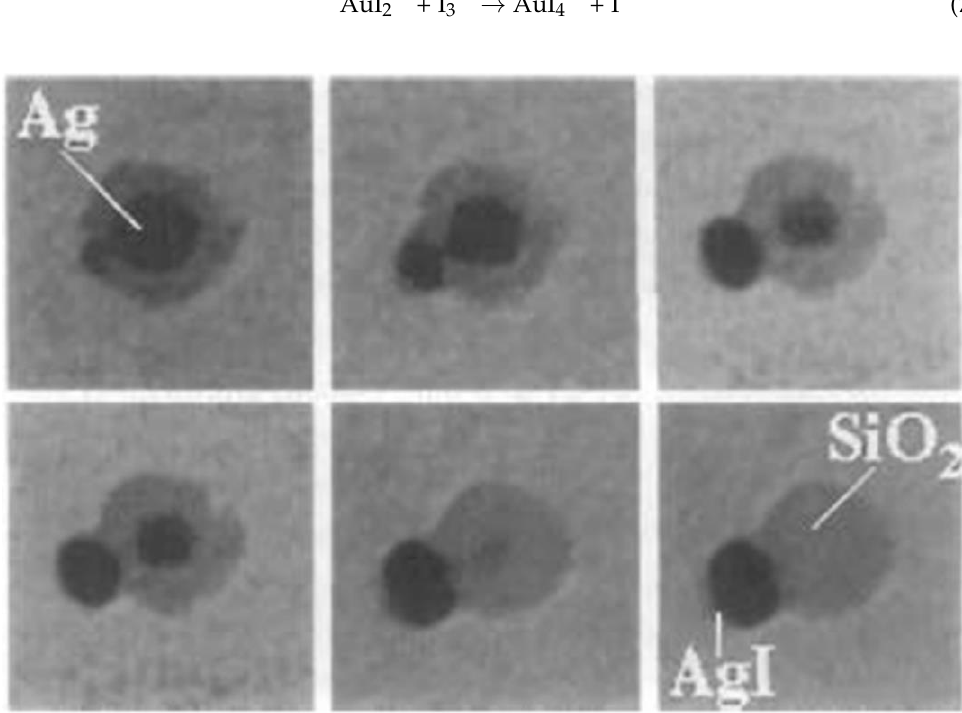
Figure 9. Electron microscope images of silica-coated silver nanoparticles exposed to I 2 for different times. Reproduced with permission from [93]. Copyright © 1997 Verlag GmbH & Co. KGaA, WeinheimNumerous studies have shown that I 2 has the ability to etch coinage noble metal NCs. Mo et al. [119] proposed that I 2 has an oxidative etching effect on lysozyme(Lys)-protected silver NCs (Lys-